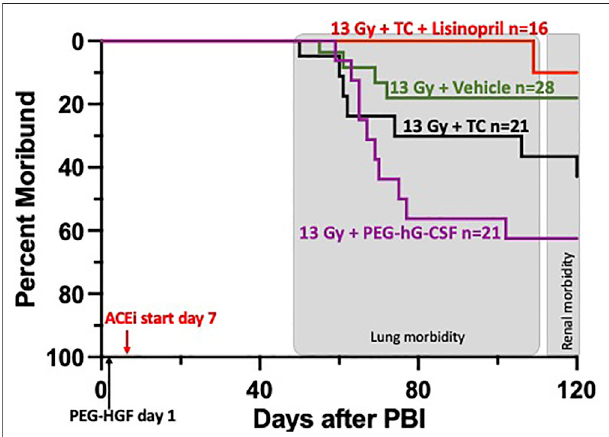
FIGURE4| Kaplan-MeierplotrepresentingmorbidityfromDEARE upto 120 days post 13 Gy partial body irradiation with one hind limb shielded (leg- out PBI). The triple combination (TC, consisting of PEG-hG-CSF, PEG mGM- CSF and PEG hIL-11), vehicle or PEG-hG-CSF (BBT-015) were given subcutaneously24 hpostleg-outPBI(designatedbyPEG-HGF)andtheACE inhibitor, lisinopril, was started in the drinking water 7 days post irradiation (24 mg m − 2 d − 1 ). All irradiated rats were given supportive care with subcutaneous hydration (40 ml kg − 1 d − 1 ) and enro fl oxacin (10 mg kg − 1 d − 1 ) from days 3 – 7 to 2 – 14, respectively,. There was trend in lower morbidity in irradiated rats that received TC + lisinopril compared to irradiated rats